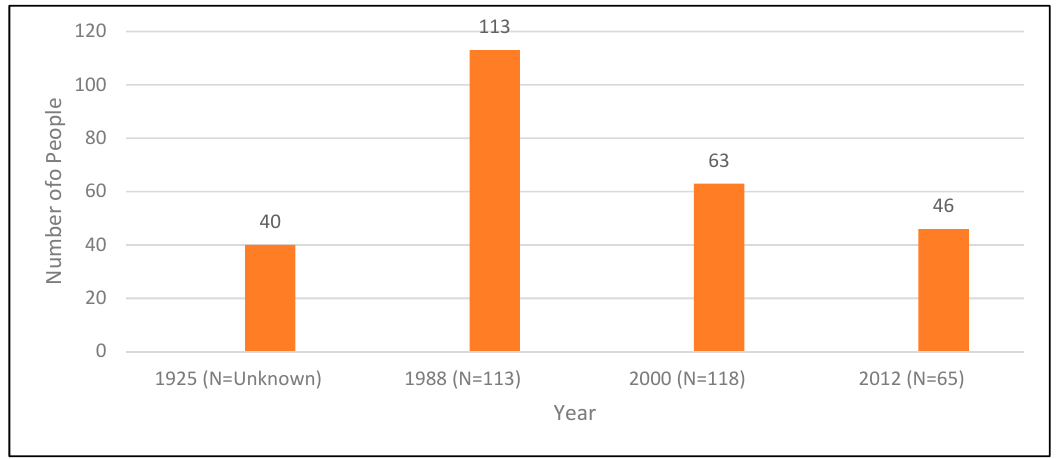
Figure 3. Number of people involved in hunting activities in the KNP between 1925 and 2012 (N = total study population). Sources: [60,68,75,76].